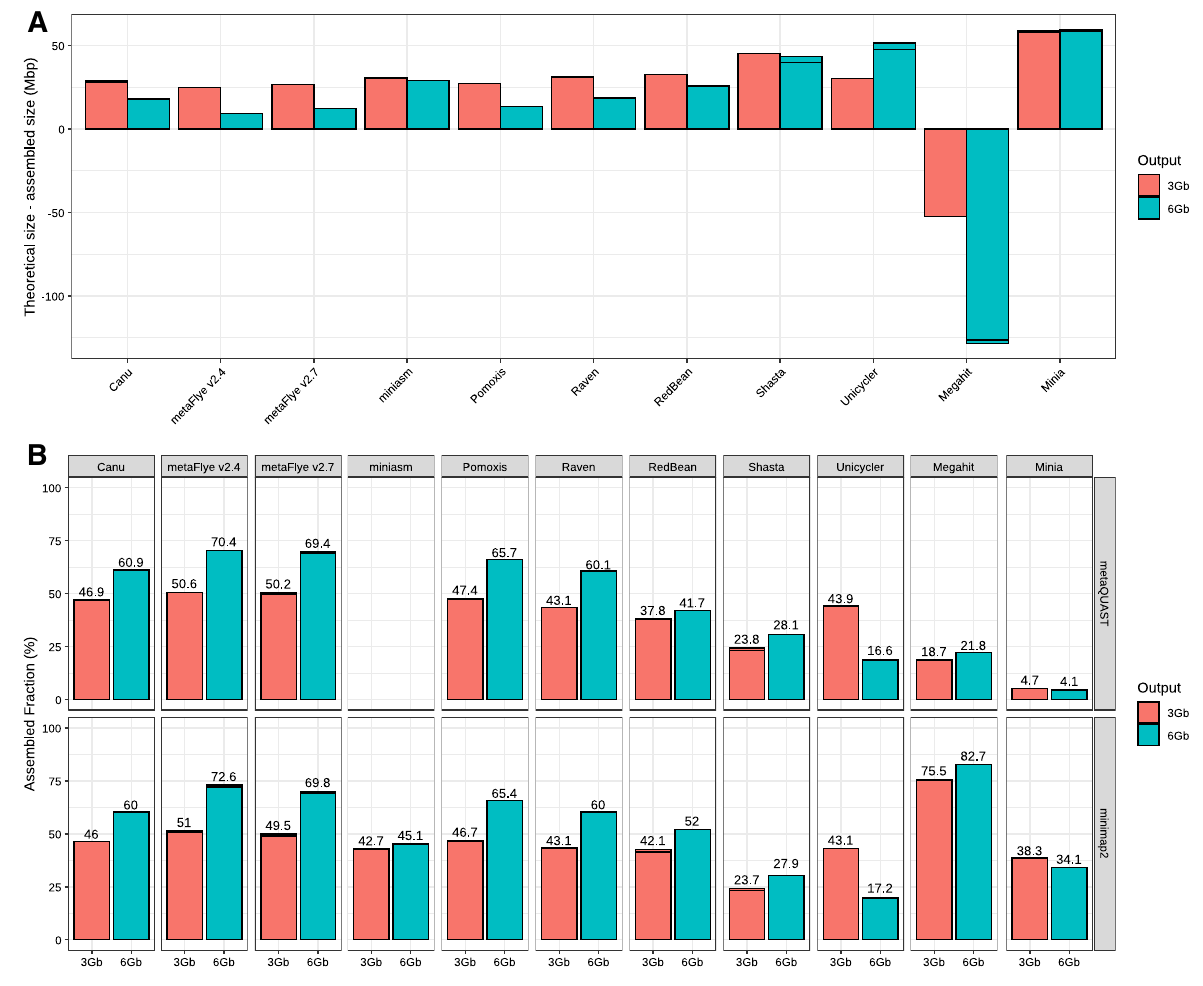
Figure 1. Evaluation of metagenome assembly size corresponding to each tested tool for the subsampled Even datasets. ( A ) Total assembled size of draft assemblies with respect to the total size of the reference metagenome; ( B ) fraction of the reference metagenome covered by the draft assembly, calculated by two different methods: metaQUAST (top panel) and minimap2 + BBTools (bottom